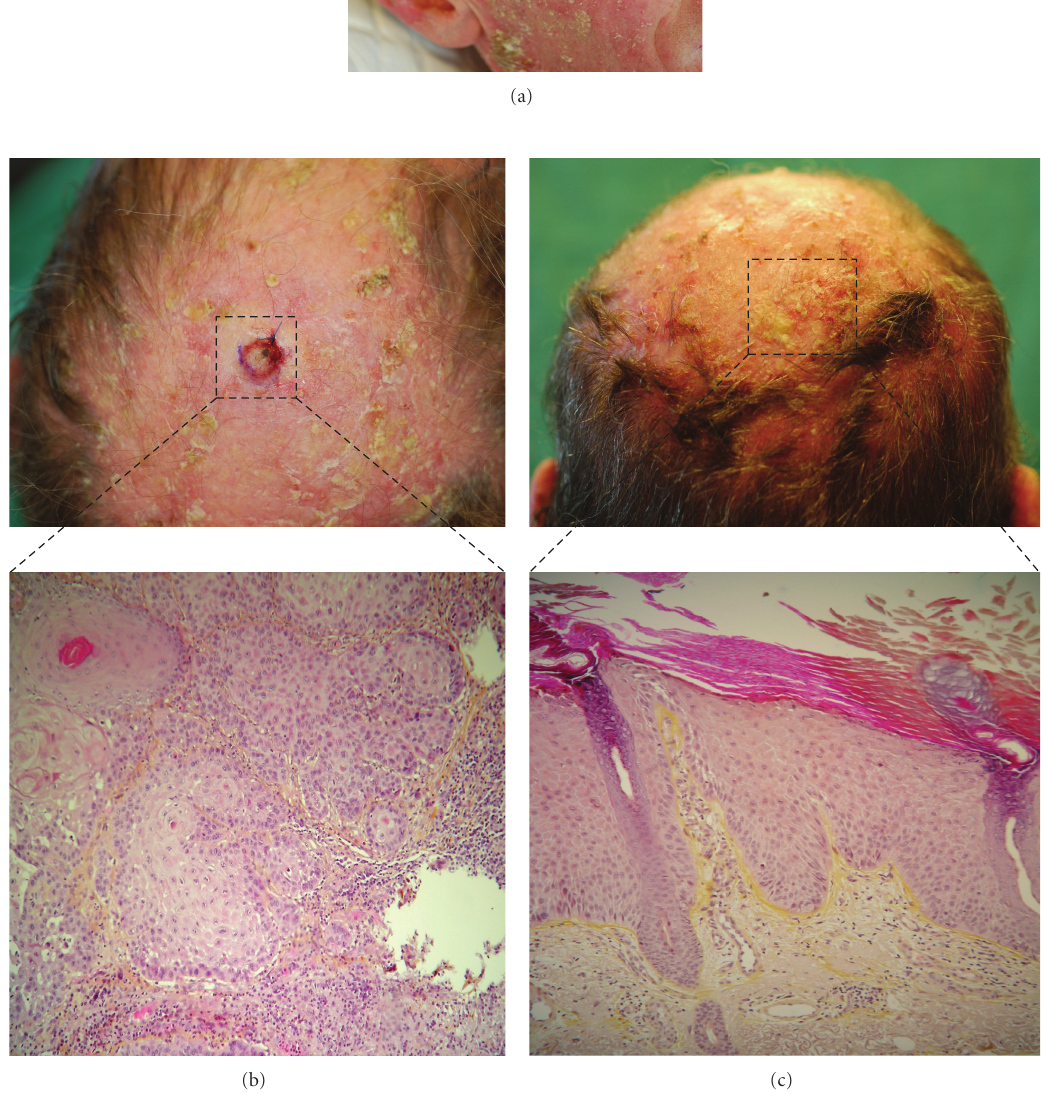
Figure 1: (a) Actinic keratosis and multiple squamous cell carcinomas of photo-exposed areas induced by voriconazole. (b) Microinvasive squamous cell carcinoma. Epithelial proliferation composed of atypical keratinocytes infiltrating the dermis, magnification × 200. (c) Actinic keratosis hyperkeratosis, slightly atypical epidermal hyperplasia; magnification ×